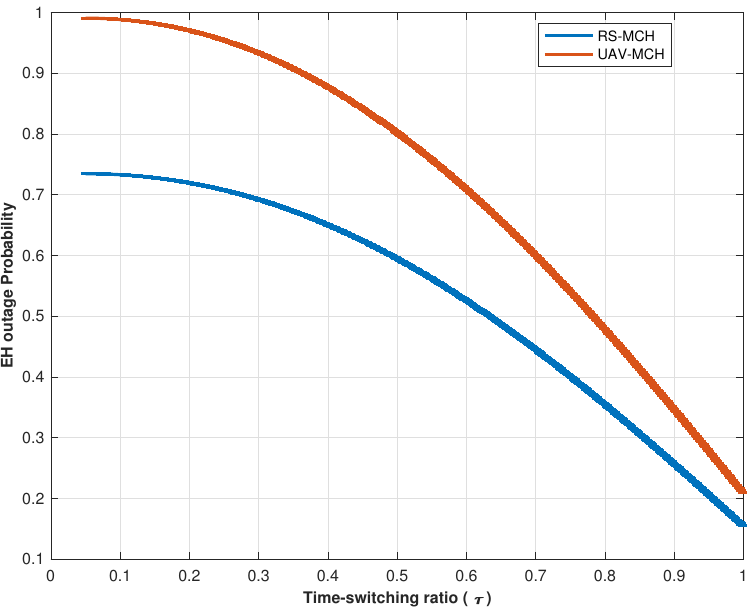
Figure 7. Comparison of EH outage probability versus time switching ratio ( τ ) for RS and UAV